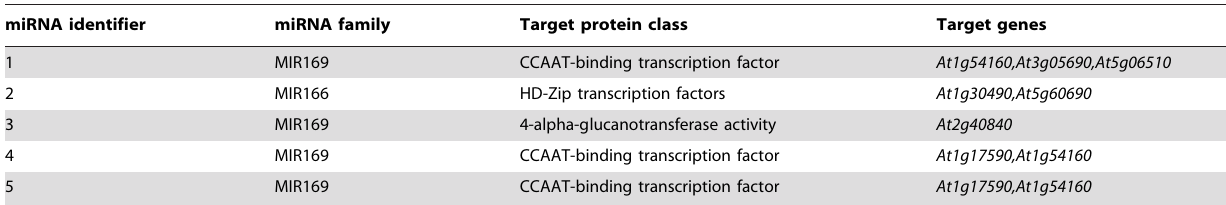
Table 4. Predicted miRNA targets.